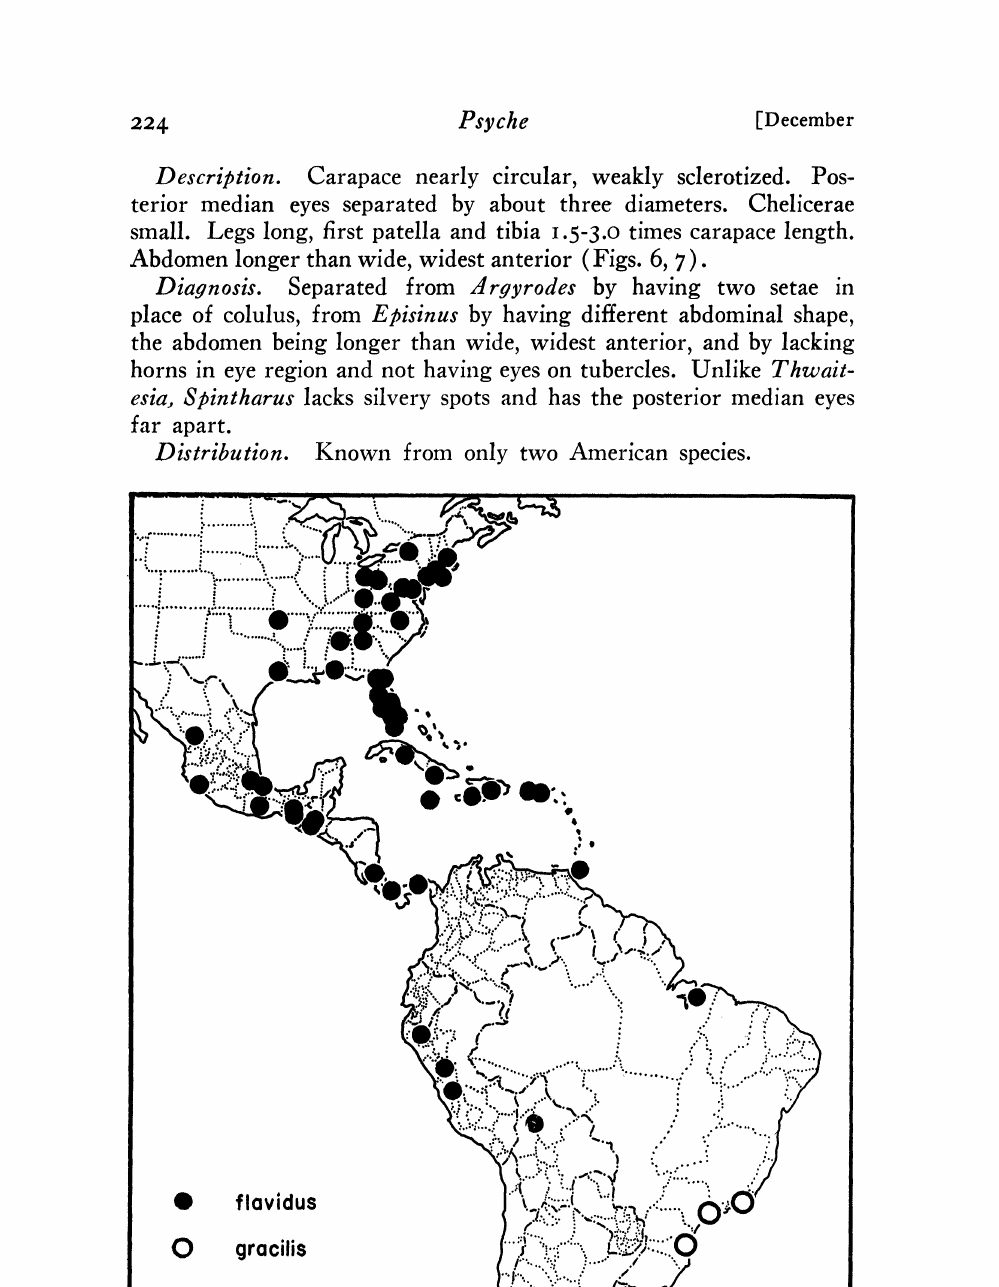
o flavidus cjracilis Map 1. Distribution of Slintharus